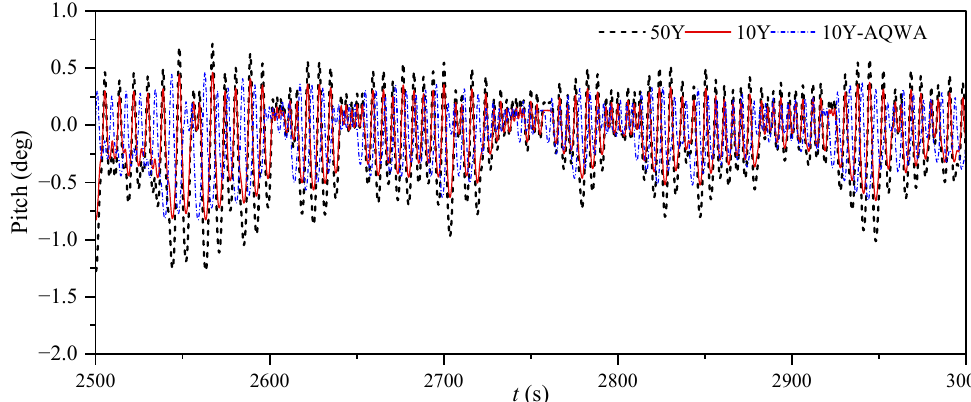
Figure 8. Surge motion of TLP under different wave heights.